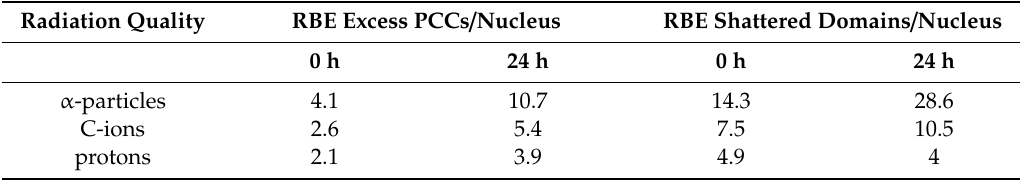
Figure 9. Persistent shattered chromosome domains at 24 h repair time, following exposure to different radiation qualities. G0 lymphocytes were irradiated with 6 Gy of α -particles, C-ions, protons or γ -rays and the yields of shattered chromosome domains were obtained, either immediately after exposure (0 h) or at 24 h post-irradiation repair time. Particle radiation-induced persistent shattered chromosome domains of the nucleus remain higher for α -particles, followed by C-ions and protons, being the least for γ -rays. Based on this cytogenetic endpoint of persistent shattered chromosome domains after 24 h, the RBE values obtained were 28.6 for α -particles, 10.5 for C-ions, and 4 for protons. (Mean ± SD based on three independent experiments; n ≥ 50 cells analyzed per experimental point; ** p ≤ 0.01, *** p ≤ 0.001). Table 1. Summary of all the RBE Values Compared with γ -rays.